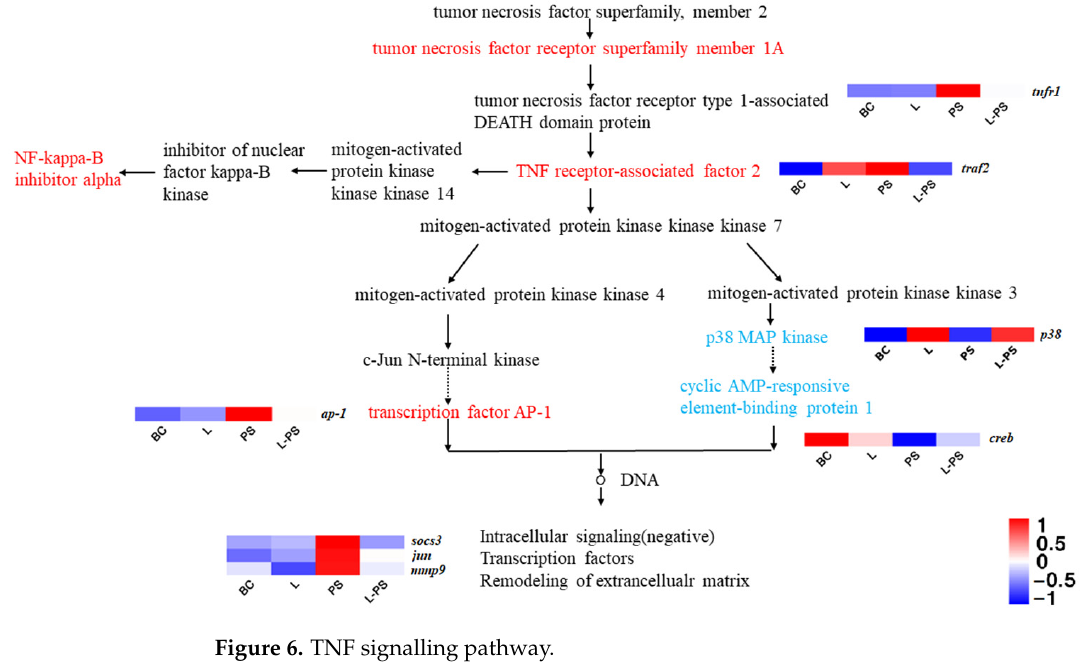
Figure 6. TNF signalling pathway.